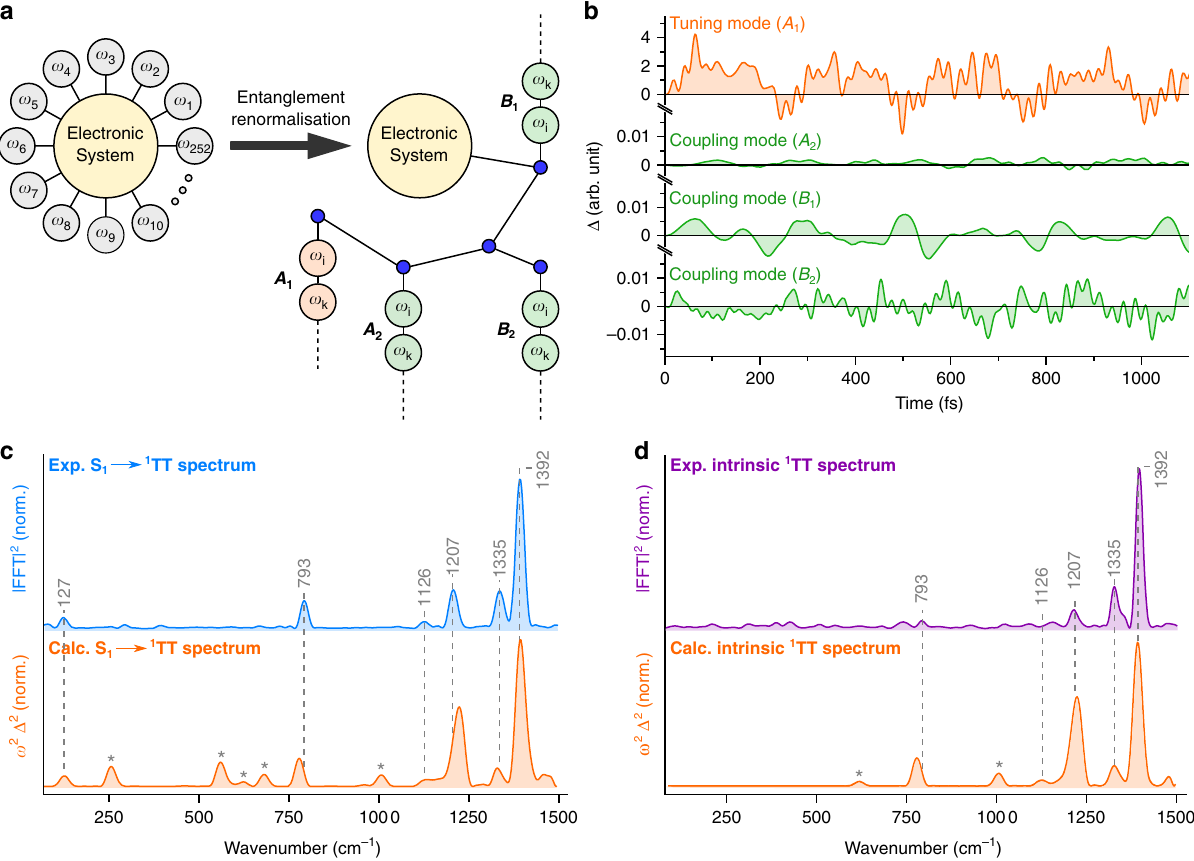
Fig. 4 TTNS simulation of singlet fi ssion in DP-Mes and structural experimental comparison. a Schematic of TTNS. The electronic system is coupled to 252 vibrational modes ( ω ) in DP-Mes. By means of entanglement renormalisation, a tree of linearly connected vibrational modes connected to the electronic system via entanglement renormalisation nodes (blue) can be created, allowing facile computation of non-Born-Oppenheimer dynamics for large molecules (>100 atoms, further details in Methods). The vibrational modes are grouped by symmetry and colour coded to indicate tuning (orange) or coupling (green) mode behaviour. b Projected total time-dependent mode displacements for all symmetry groups and their corresponding assignment. We remark the ~200-fold lower displacement amplitude for A 2 , B 1 and B 2 modes compared with the A 1 modes. c S 1 → 1 TT coherence transfer Raman spectrum (blue) and resonance Raman representation of the calculated spectrum (orange). d Intrinsic 1 TT Raman spectrum (purple) compared with the resonance Raman representation of calculations initiated in 1 TT (orange). Calculated modes marked with an asterisk in ( c ) and ( d ) are not detected in the experimental spectrum, likely due to resonance Raman enhancement groups of vibrational tensors are connected (i.e. coupled) to the tensor representing the electronic system (Fig. 4a, left). This